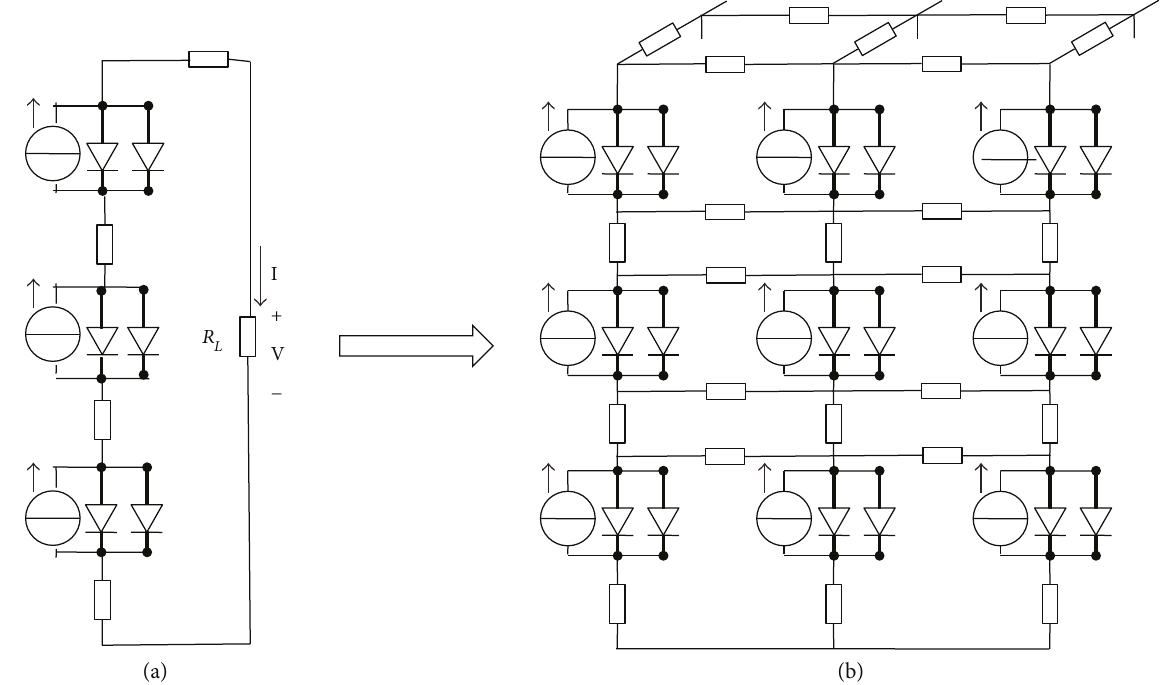
Figure 7: The circuit network model of triple-junction cells under nonuniform illumination.